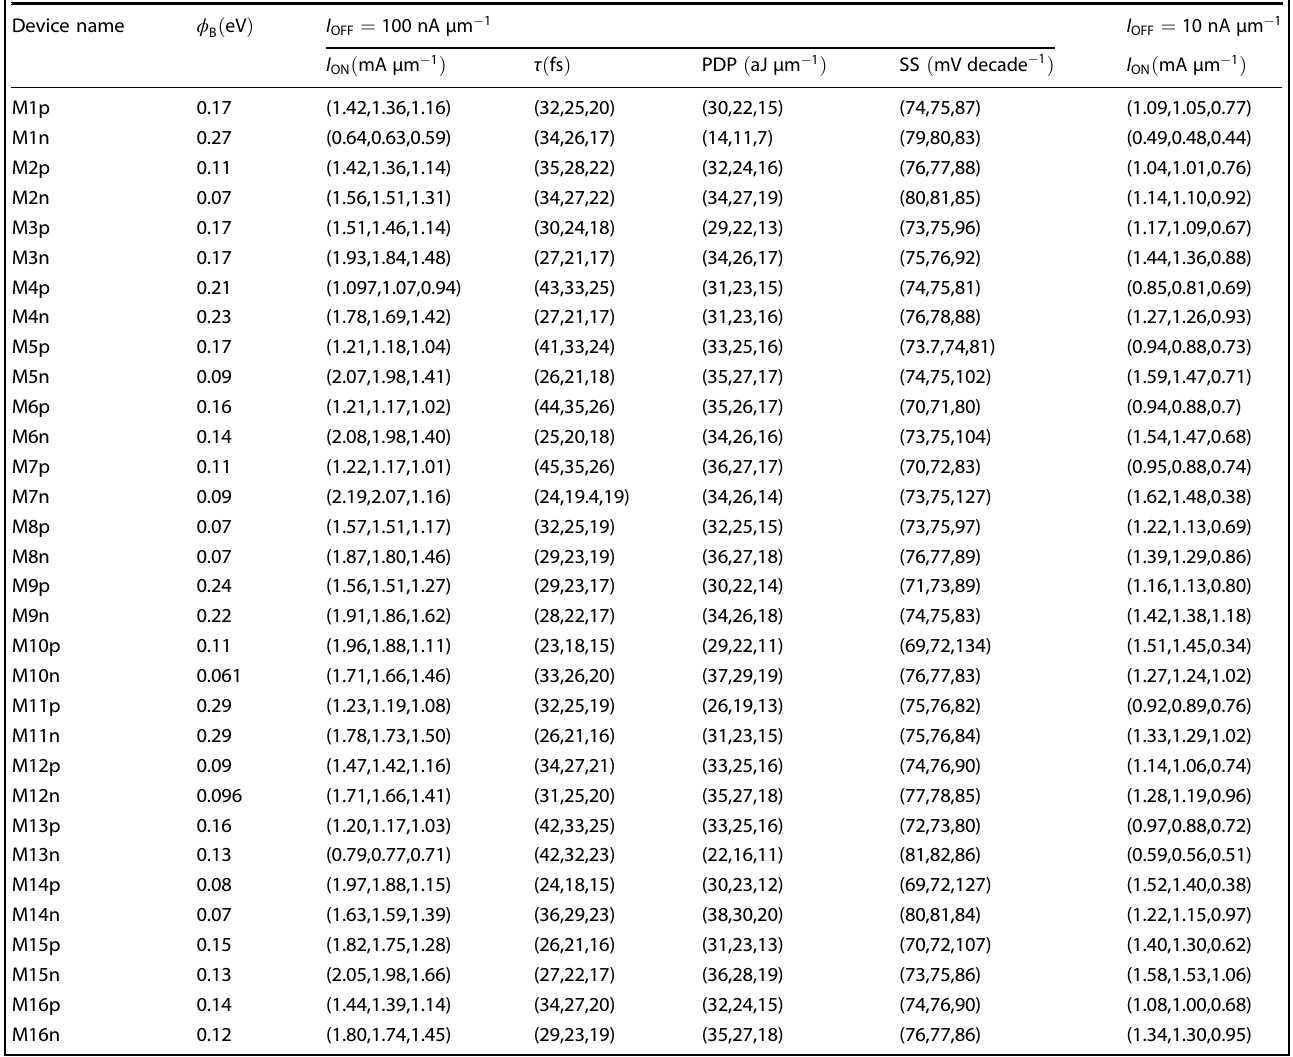
Table 2. Figure of merits of 16 complementary transistors. Triplets are in the order of descending channel length. Device